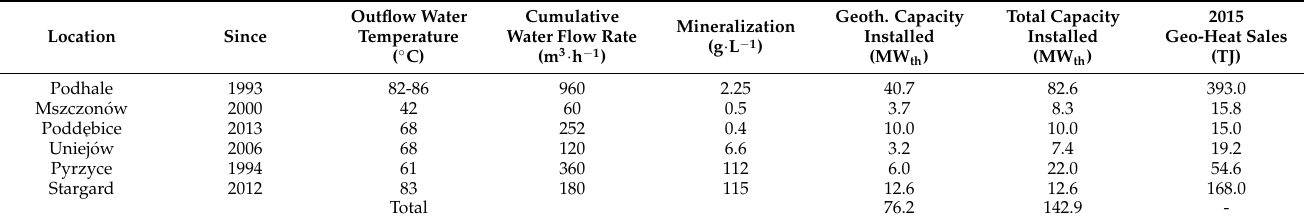
Table 1. Geothermal district heating (GeoDH) plants in Poland, 2020 [49].